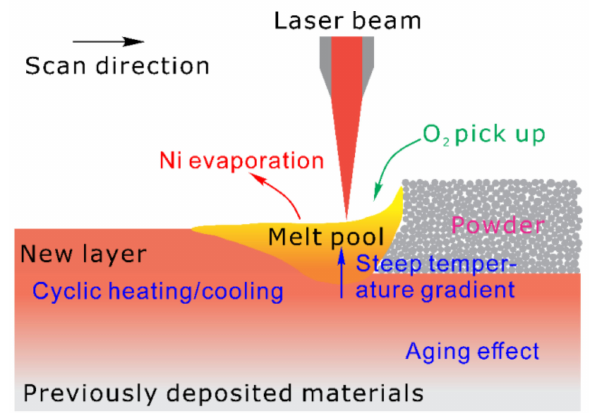
Figure 1. Schematic of the melt pool behavior of the selective laser melting process.